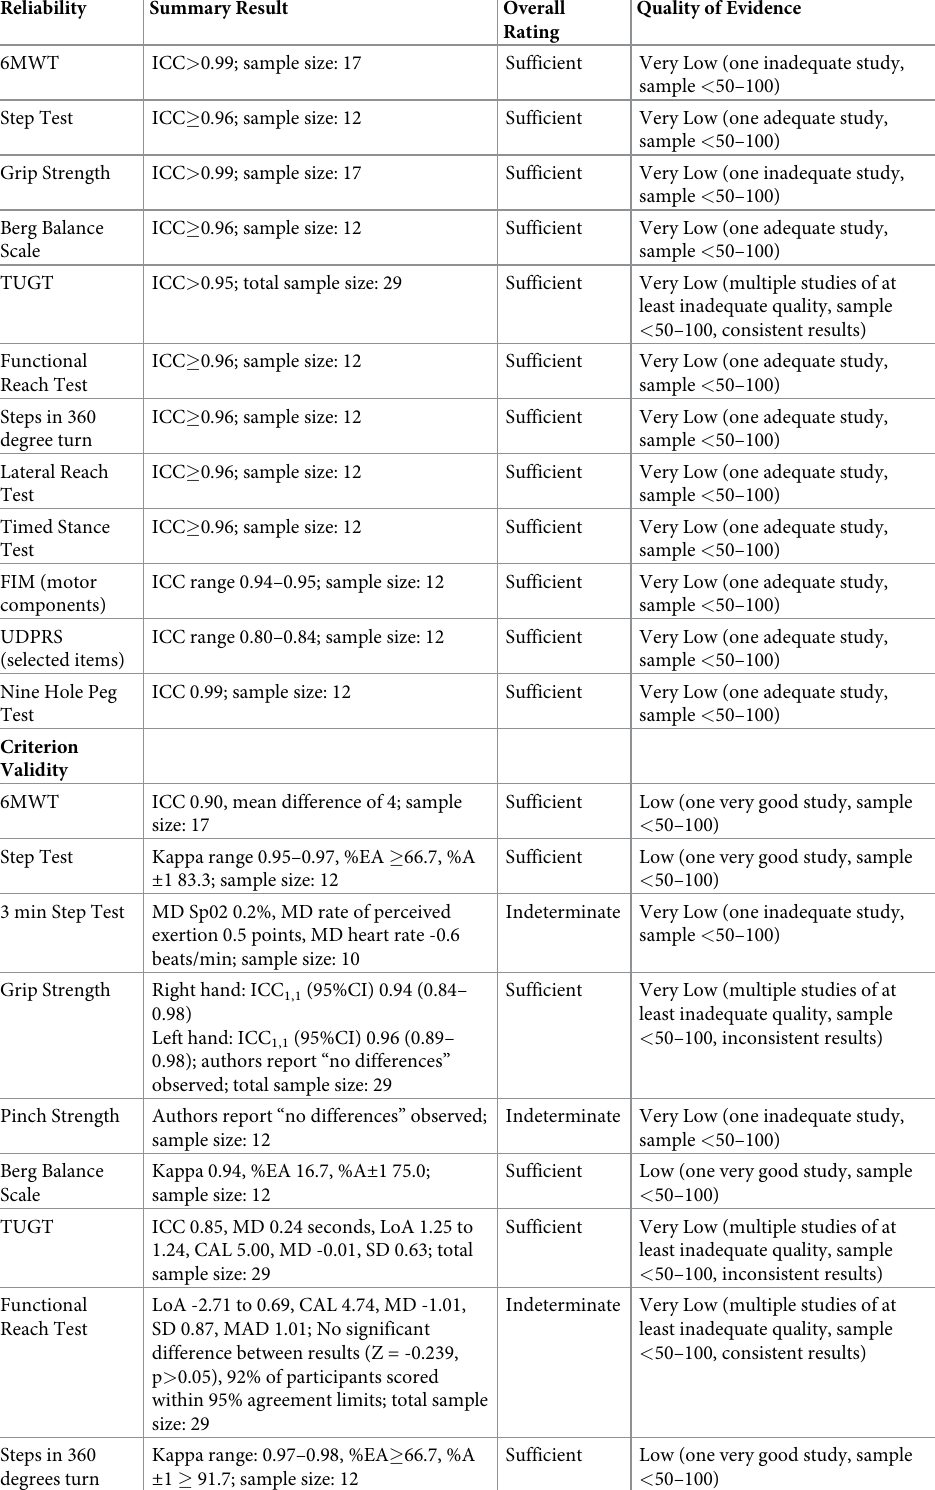
Table 3. Summary of